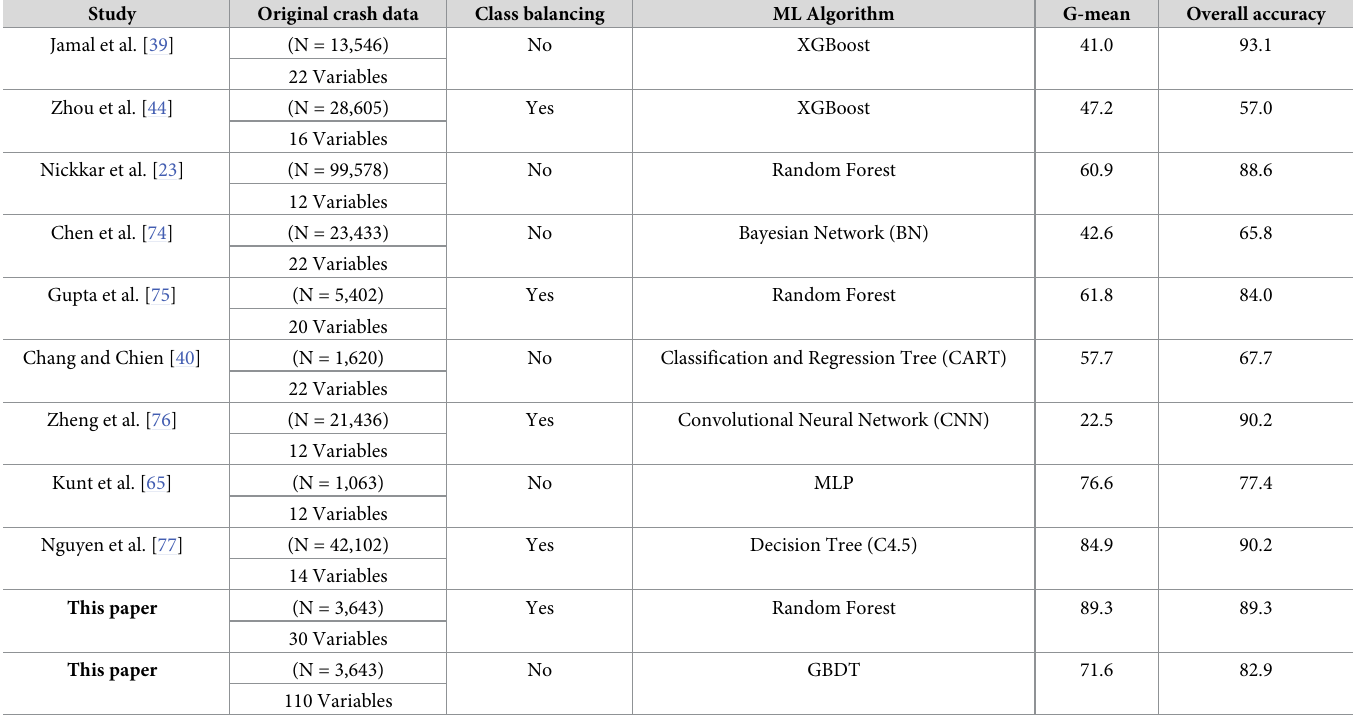
Table 4. Comparison of crash severity prediction performance of proposed models with previous